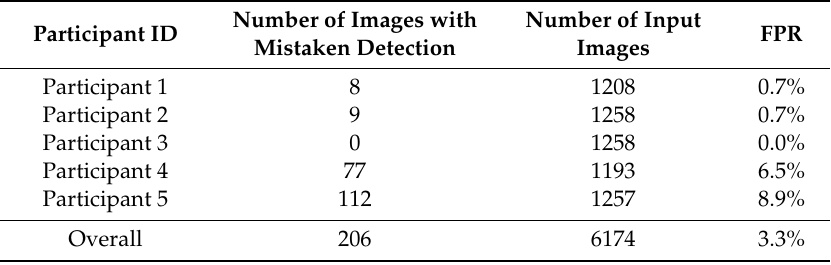
Table 1. Measured FPR of eye torsion